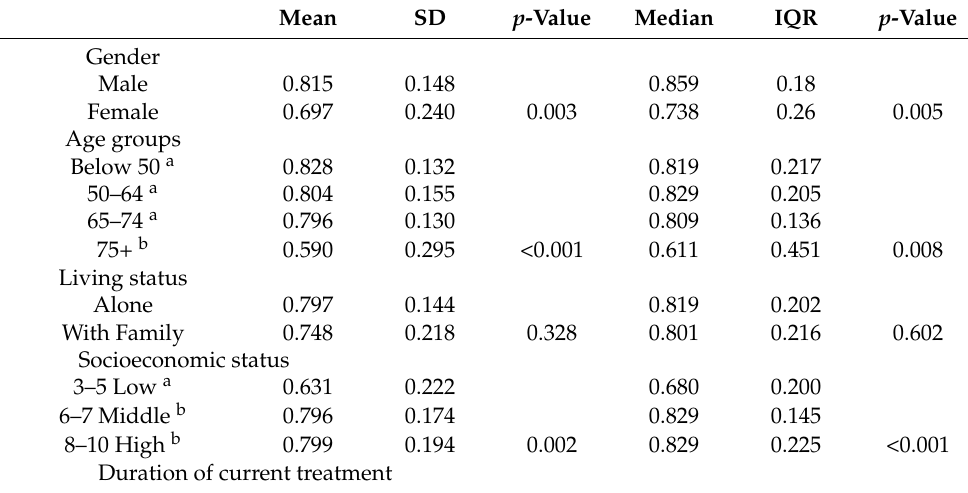
Table 4. EQ-5D-5L scores by sociodemographic